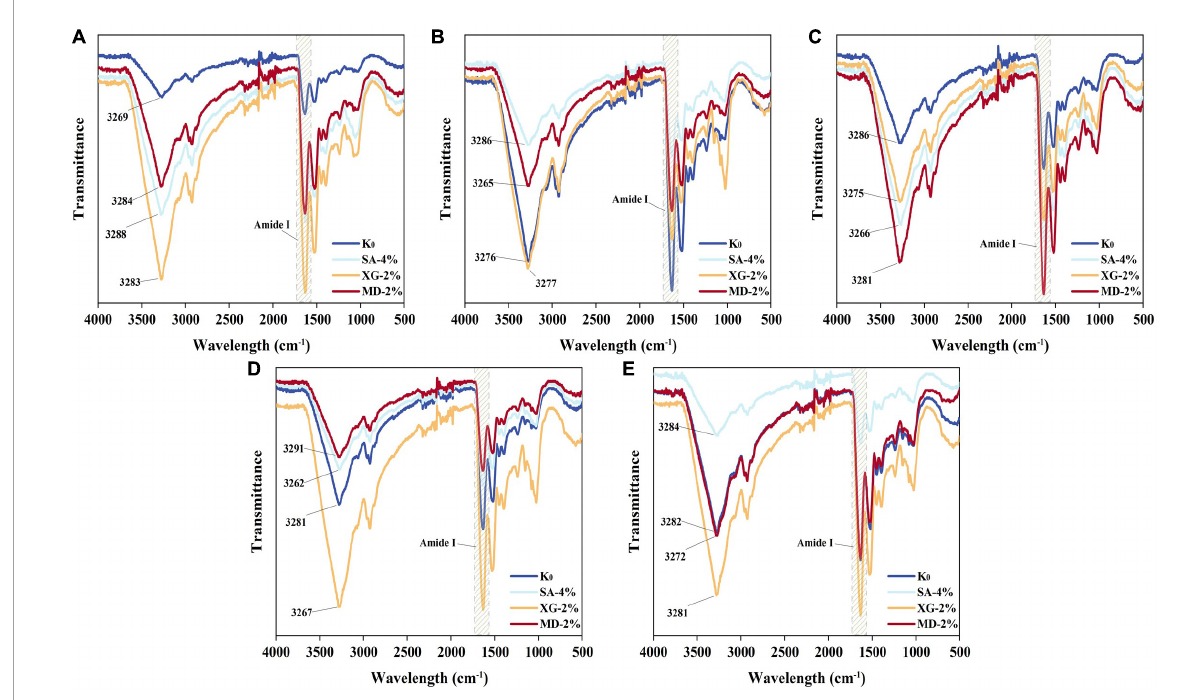
FIGURE4 Fourier transform infrared spectroscopy (FT-IR) spectra for extrudates in different zones. (A) Mixing zone, (B) Heating zone, (C) Melting zone, (D) Die zone, and (E) Cooling